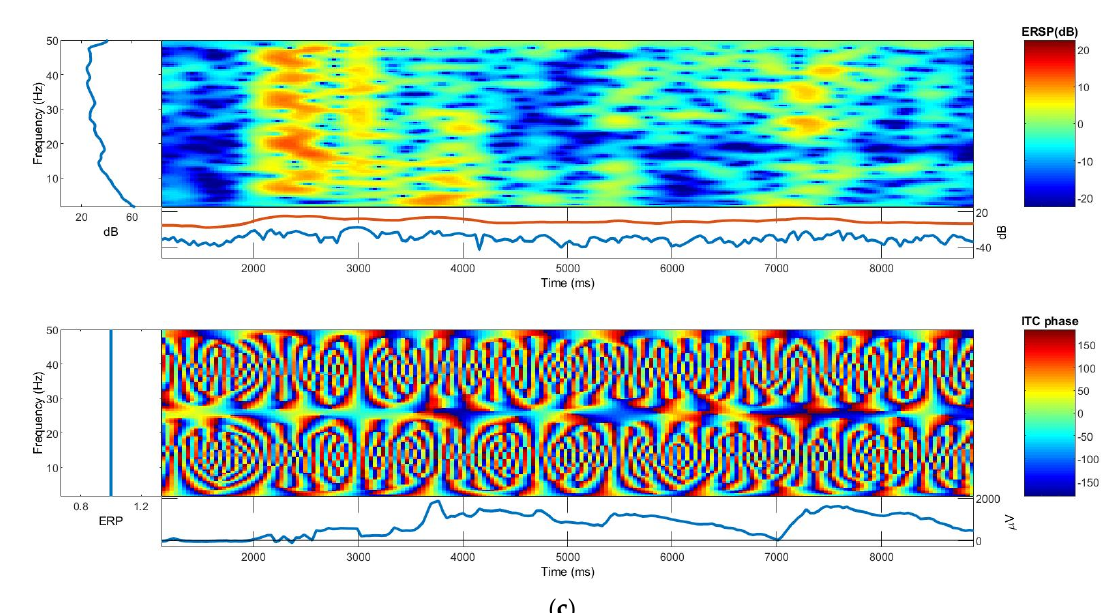
Figure 15. ( a ) Electroencephalography (EEG) signals from the textile electrode; ( b , c ) event-related spectral perturbation (ERSP) and intertrial coherence (ITC) plots: ( b ) textile electrode and ( c ) dry Ag/AgCl electrode.